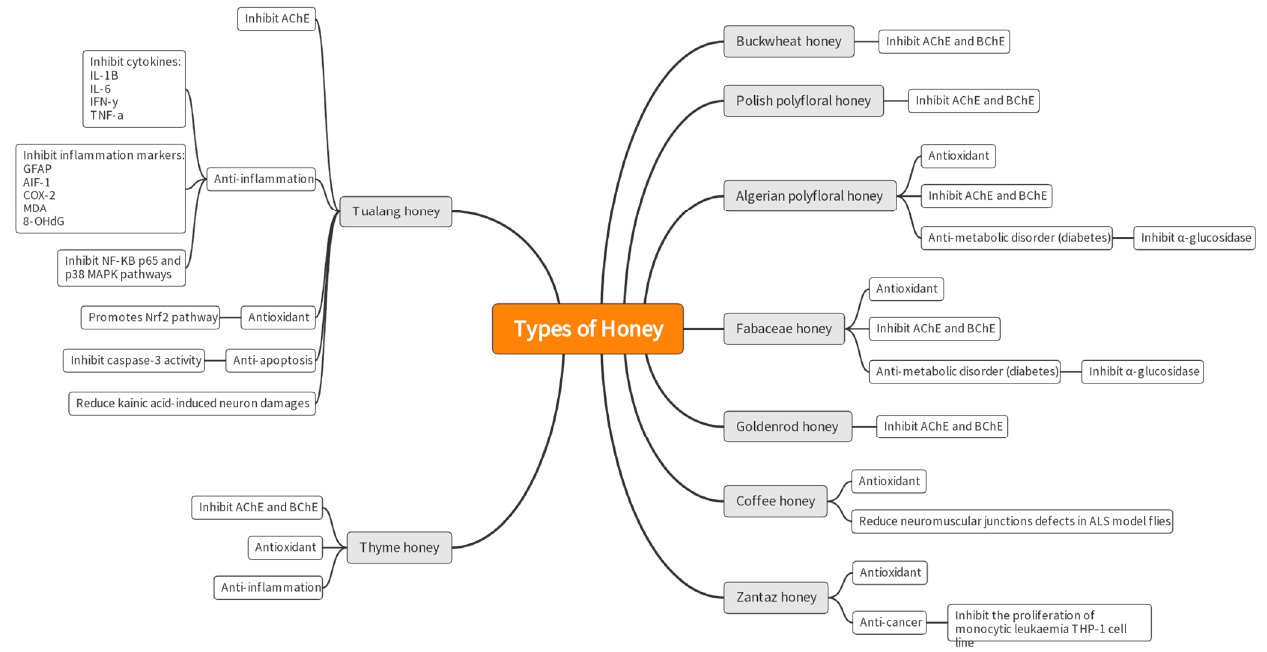
Figure 2. Summary of the types of honey and their potential for neuroprotection from the articles compiled.